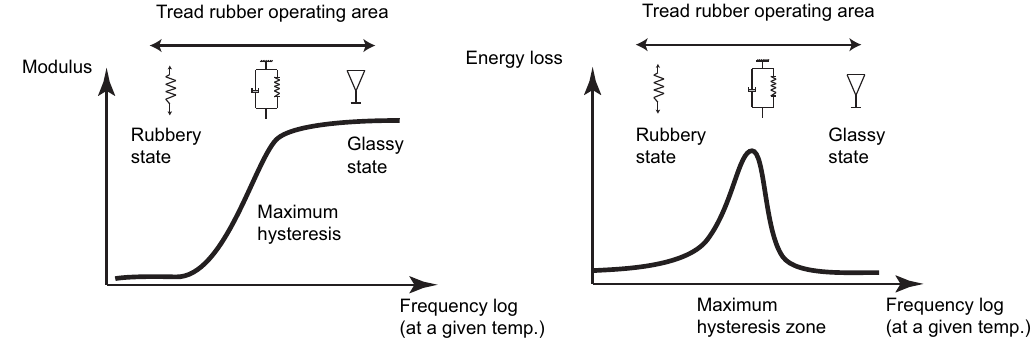
Figure 4. The influence of stress frequency on the tyre as a viscoelastic material. The modulus of elasticity becomes maximum above a stress frequency threshold. Hysteresis (energy loss) is maximum at this threshold and reduces at frequencies different to that